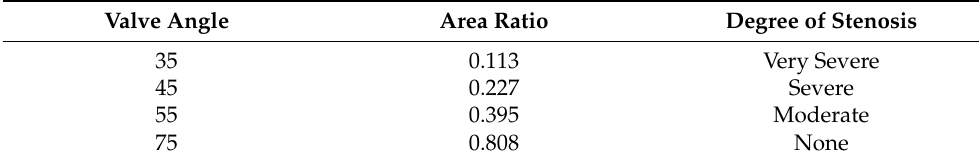
Table 2. Degrees of stenosis. Valve